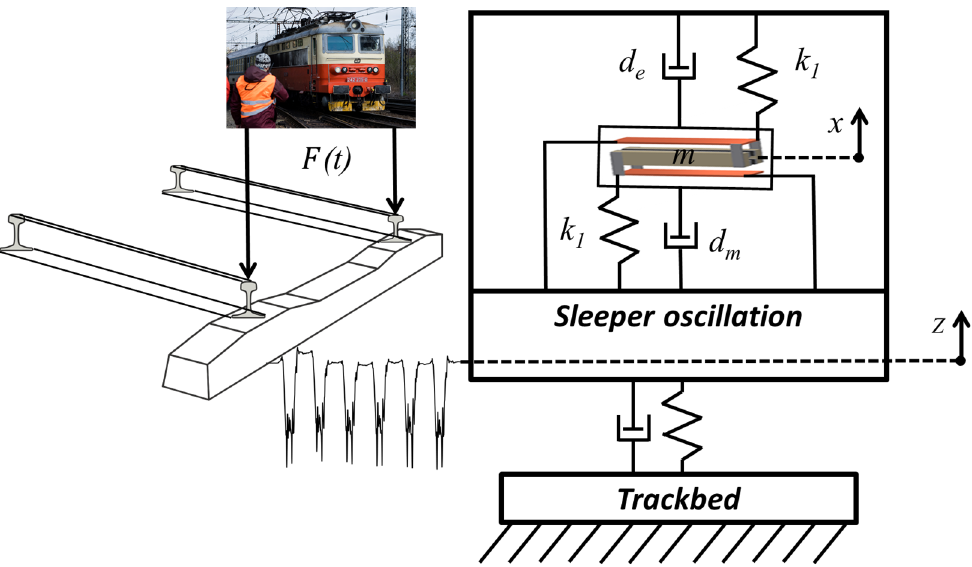
Figure 1. Physical principle of kinetic energy harvester under passing train